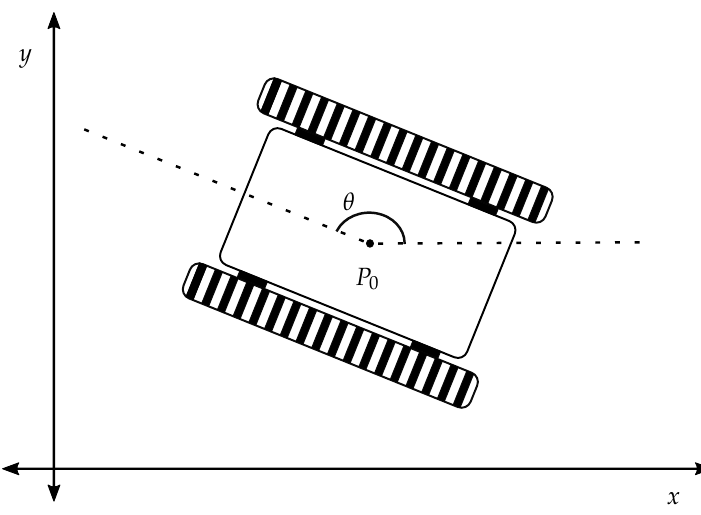
Figure 5. Schematic representation of a tracked robot, where x and y are the coordinates of P 0 and θ is the heading